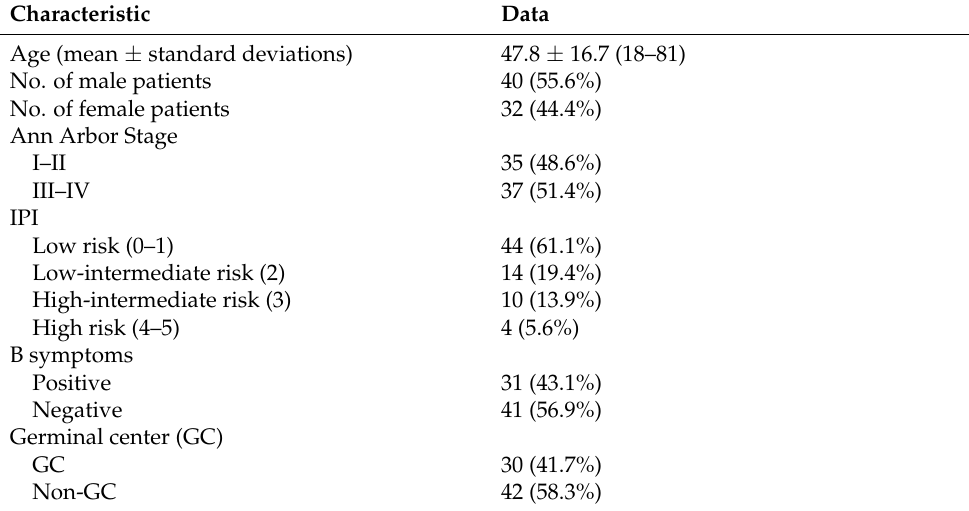
Table 1. Characteristics of the 72 patients with diffuse large B cell